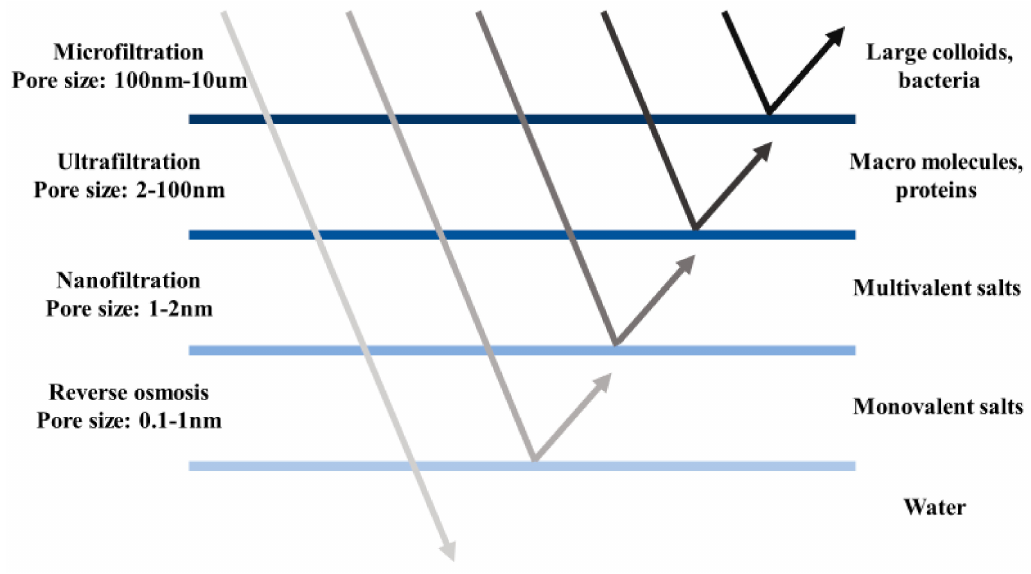
Figure 1. Classification of membranes for water purification in terms of pore size and retained